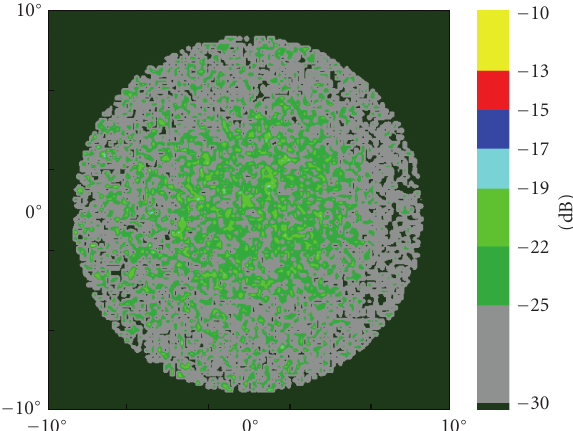
Figure 9: Minimum isolation of DBS beams, biased for gain, 7 colour, with errors, (scale − 31 to −